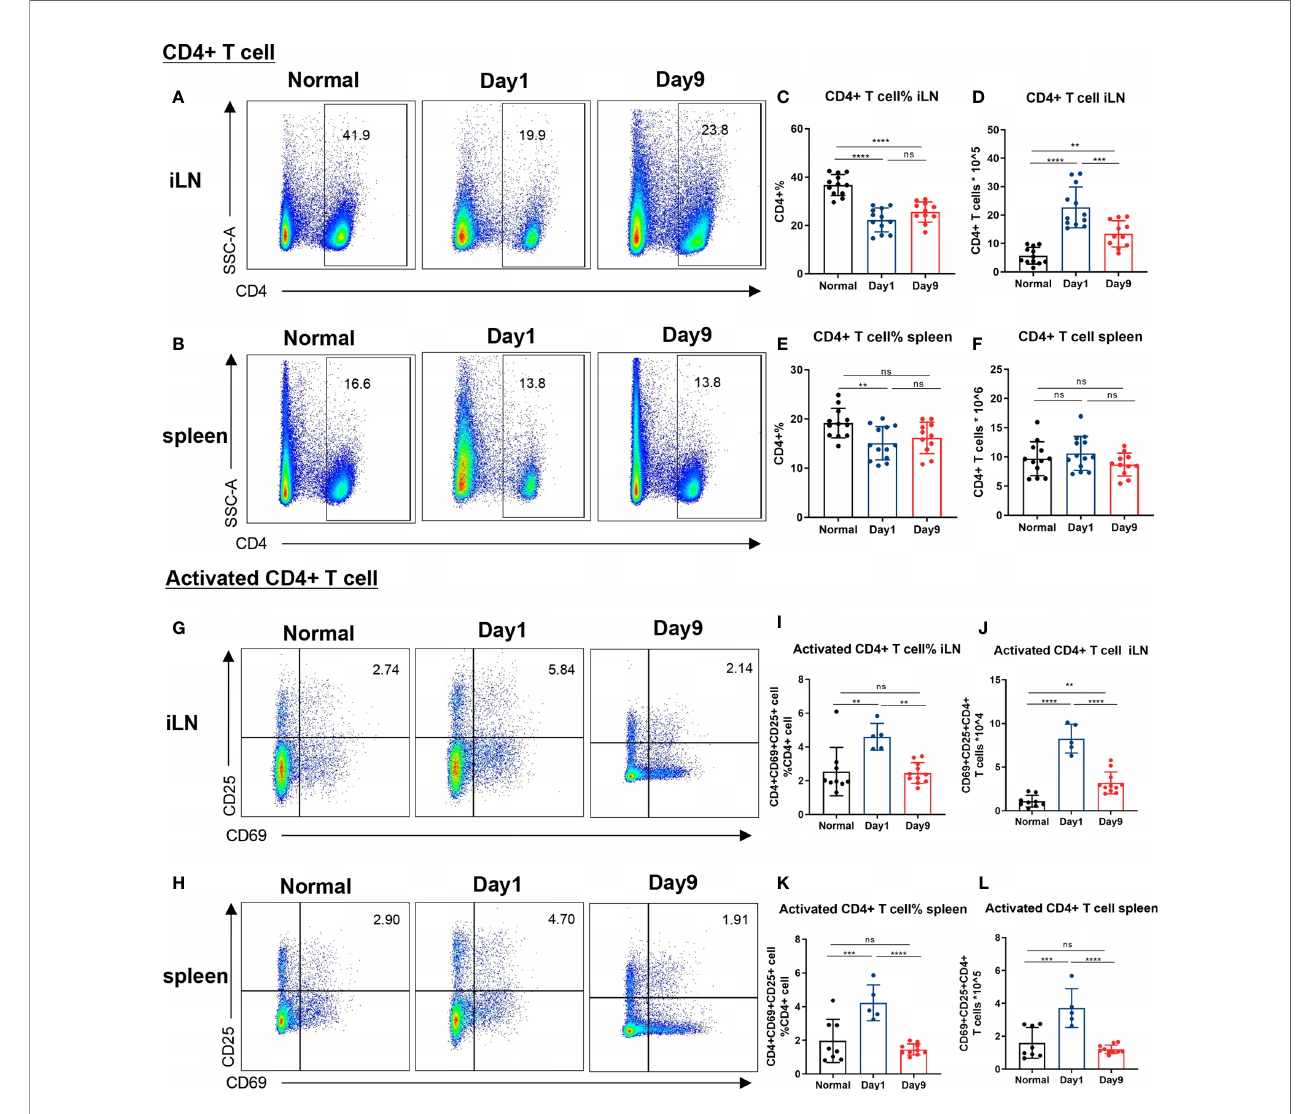
FIGURE 2 | Levels of CD4+ and activated CD4+ T cells in lymph nodes and spleen of DTHA mice. Relative and absolute levels of CD4+ and activated CD4+ T cells isolated from draining inguinal lymph node (iLN) and spleen of normal mice and DTHA-induced mice on day 1 and day 9 post the mBSA challenge. (A, B) Representative fl ow cytometry dot plot of CD4+ T cell from iLN (A) and spleen (B) . (C – F) Quanti fi cation of relative and absolute number of CD4+ T cells from iLN (C, D) and spleen (E, F) . (G, H) Representative levels of activated CD4+ T cells (CD4+CD69+CD25+) from iLN (G) and spleen (H) . (I – L) Relative number and absolute number of activated CD4+ T cells from iLN (I, J) and spleen (K, L) on day 1 and day 9. Data is presented as mean ± SD. All data pooled from two independent experiments (at least fi ve mice per group in each experiment) with the exception of the data of activated CD4+ on day 1, which is from one experiment with fi ve mice. Statistical signi fi cance was calculated by ANOVA with Tukey multiple comparison test (**p < 0.01, ***p < 0.001, ****p < 0.0001, ns: p >